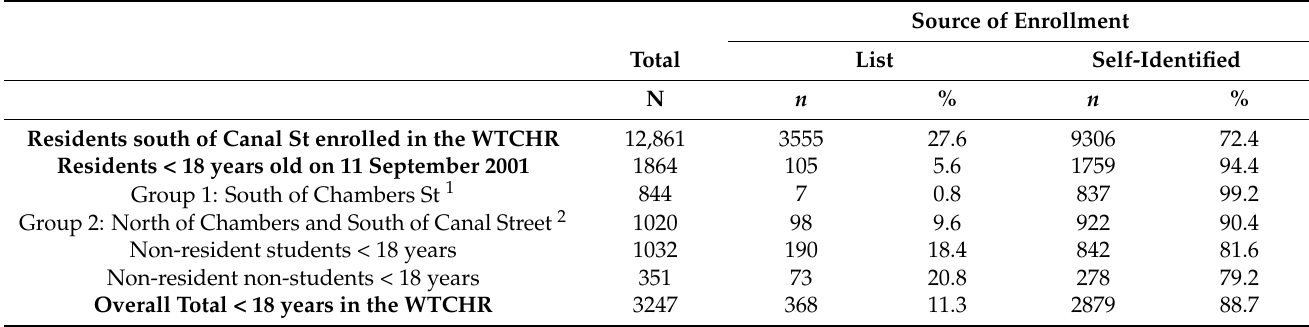
Table 1. Source of enrollment (list or self-identified) for WTCHR residents, residents < 18 years on 11 September 2001, non-resident students, and non-resident